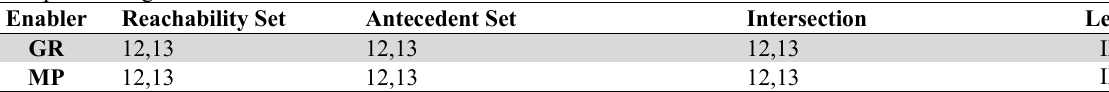
Level partitioning Iteration 9 Enabler